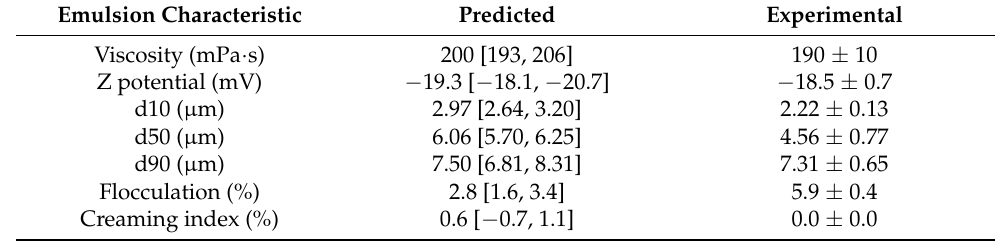
Table 4. Predicted [prediction bounds (95%)] and experimental values of the optimum emulsion char- acteristics.